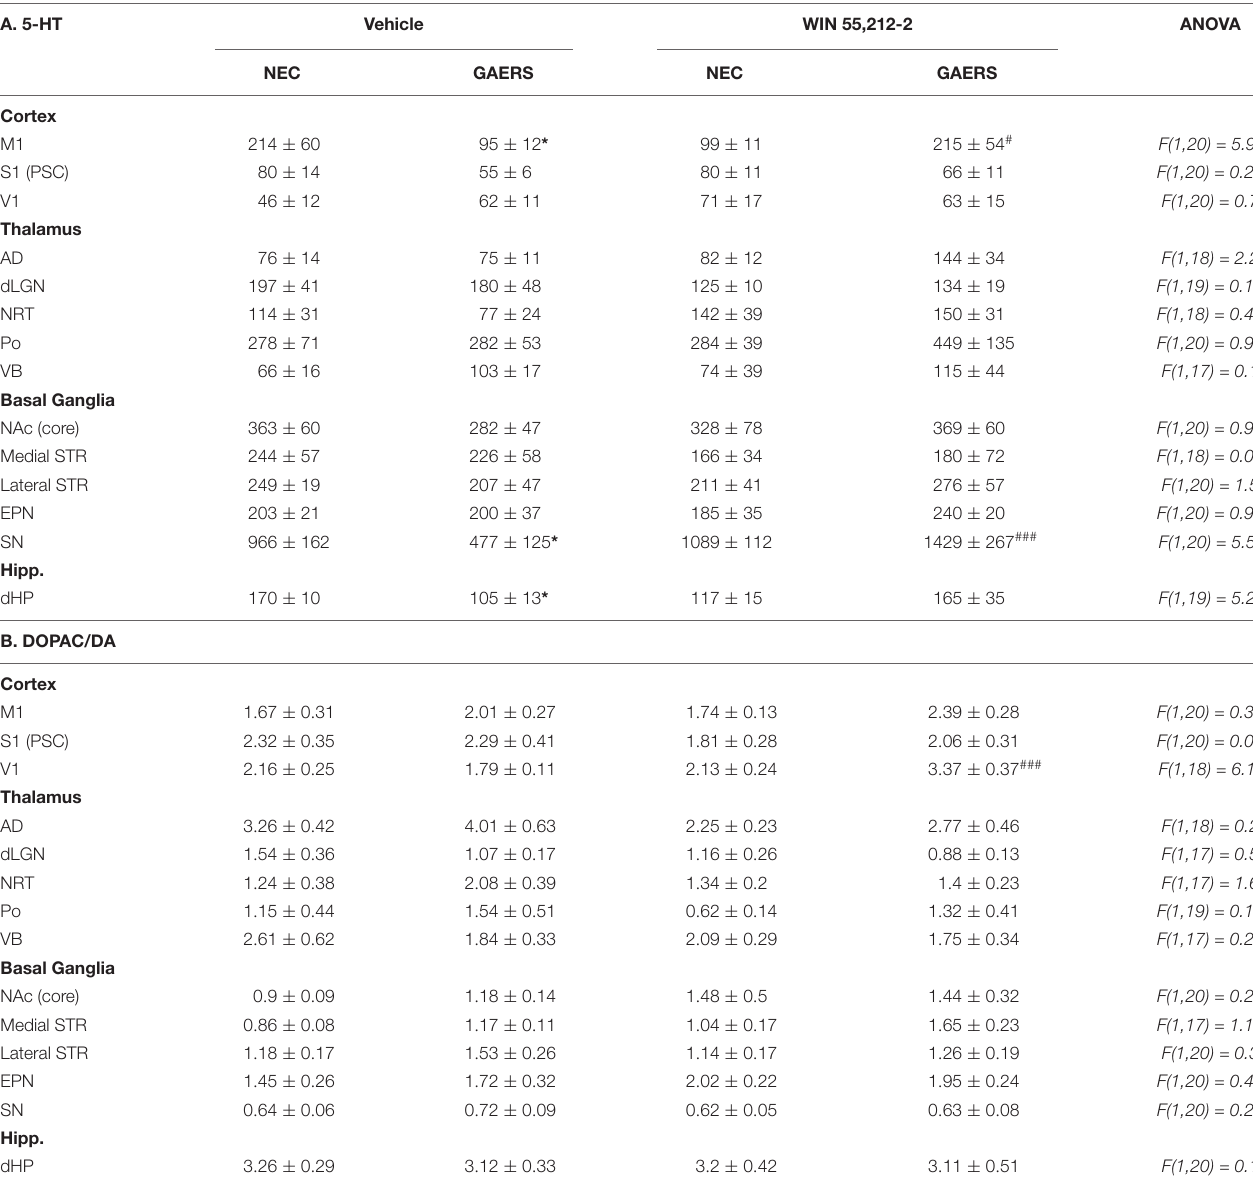
TABLE 3 | Effect of WIN 55,212-2 and its vehicle on 5-HT tissue content and the ratio 5-HIAA/5-HT in selected brain regions of GAERS and NEC